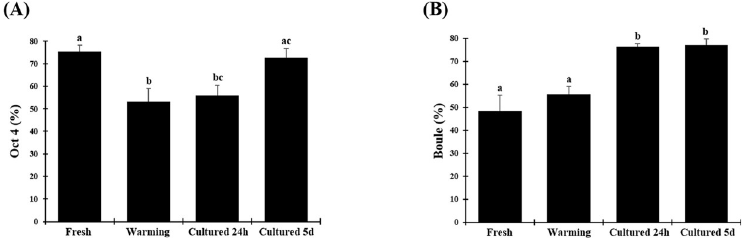
Fig 9. Evaluation of germ cell progression on testicular tissue from prepubertal cats after vitrification and culture using specific markers. (A) Percentage of cells labelled with Oct4 (spermatogonia, pre-meiotic stage), (B) Percentage of cells labelled with Boule (spermatocytes, meiotic stage). Data are expressed as mean ± SE (n = 5 animals per treatment). Different letters above bars indicate significant statistical differences between treatments (P <